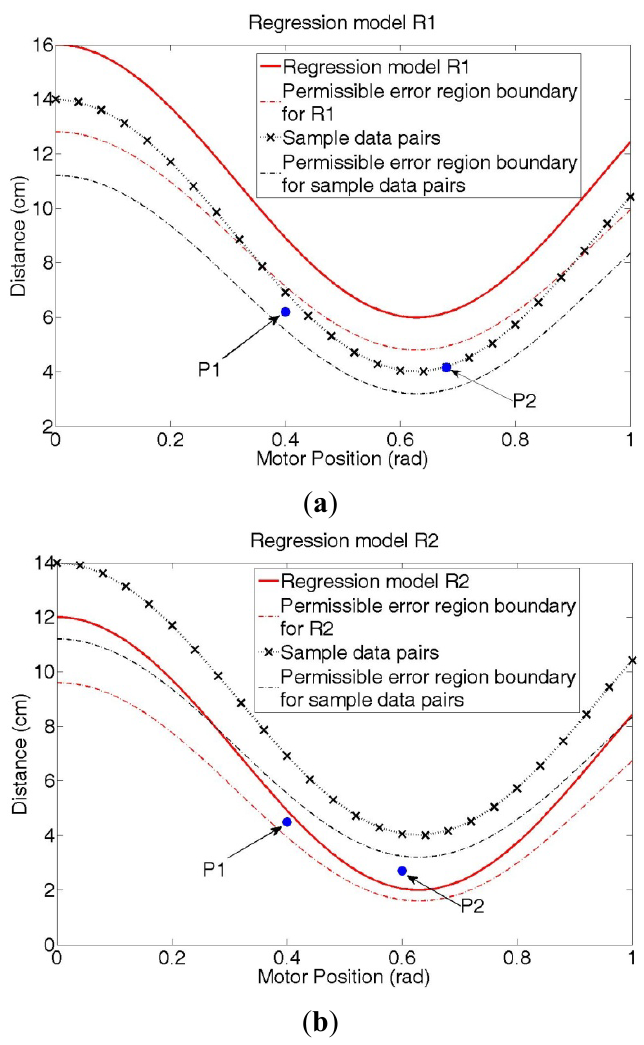
Figure 5. Two different regression results: ( a ) Regression model R1—Estimated distance values are larger than measured distance values. ( b ) Regression model R2—Estimated distance values are smaller than measured distance